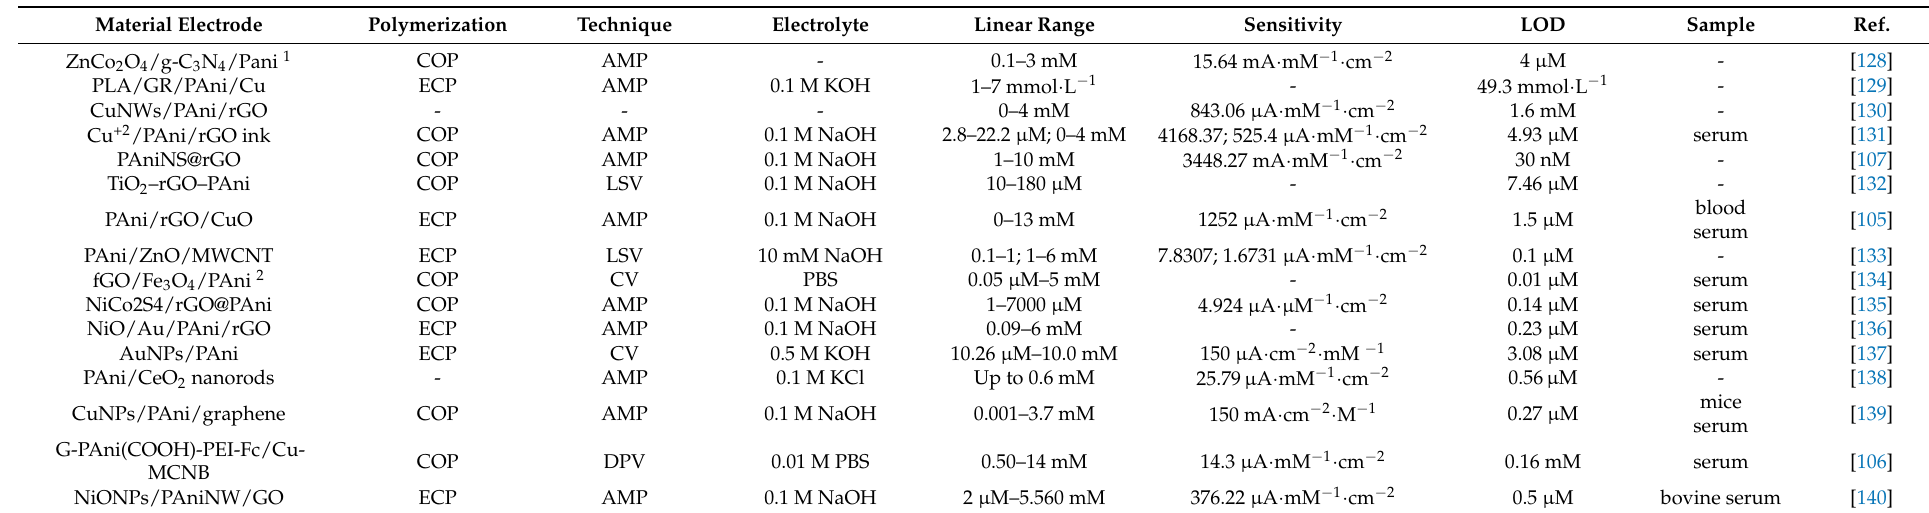
Table 4. Non-enzymatic PAni/Carbon-based materials/nanomaterials glucose